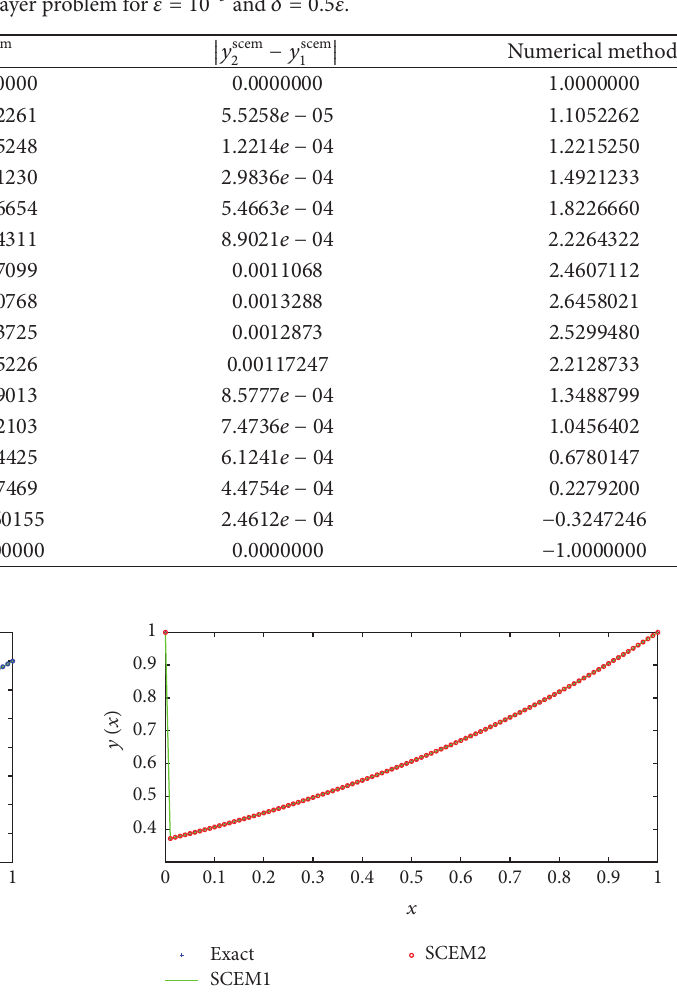
Figure 3: Left layer problem for 𝜀 = 0.001 and 𝛿 = 0.9𝜀 .